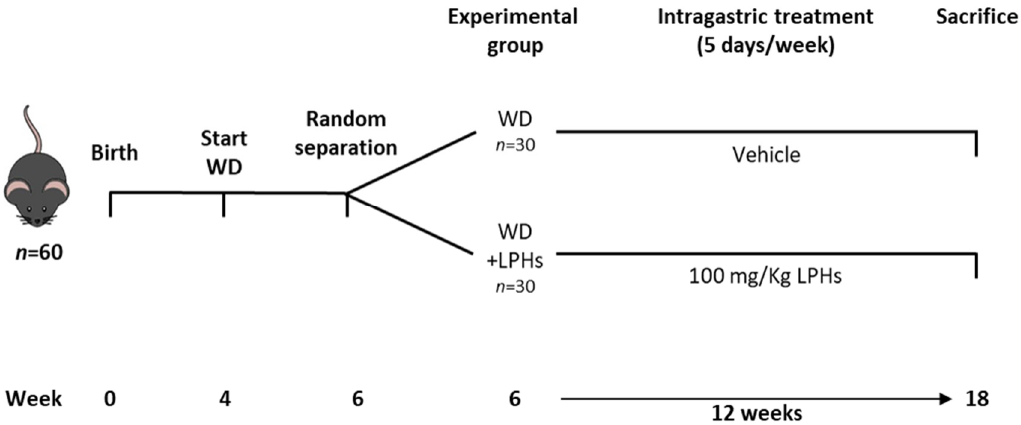
Figure 1. Experimental design and timeline. Schematic diagram of the experimental design of the study. WD, Western diet; LPHs, lupin protein hydrolysates.